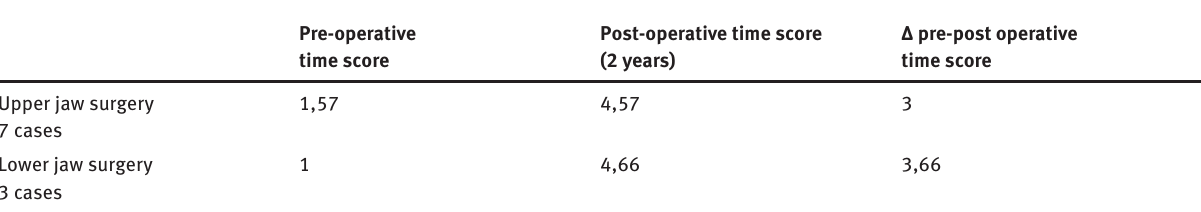
Table 1: Mean aesthetic evaluation of 10 patients operated by distraction techniques selected at pre-operative, post-operative (2 years) and relative difference pre- to post-operative time following Likert scale